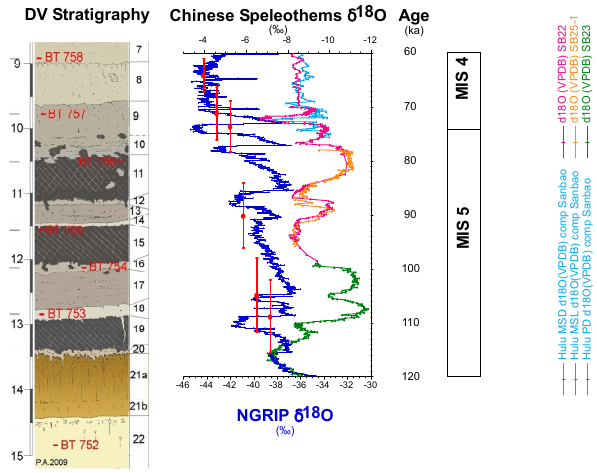
Fig. 6. Dating of DV soil complexes, via correlations with several well-dated records, over the 60–120ka interval. Left: observed DV stratigraphy; middle: mean position of the DV Optical Stimulated Luminescence (OSL) dates in the Greenland NGRIP δ 18 O stratig- raphy (Andersen et al., 2004); and right: comparison between the NGRIP (Andersen et al., 2004) and the Chinese speleothem δ 18 O stratigraphies from the Hulu and Sangbao caves (Wang et al., 2001,